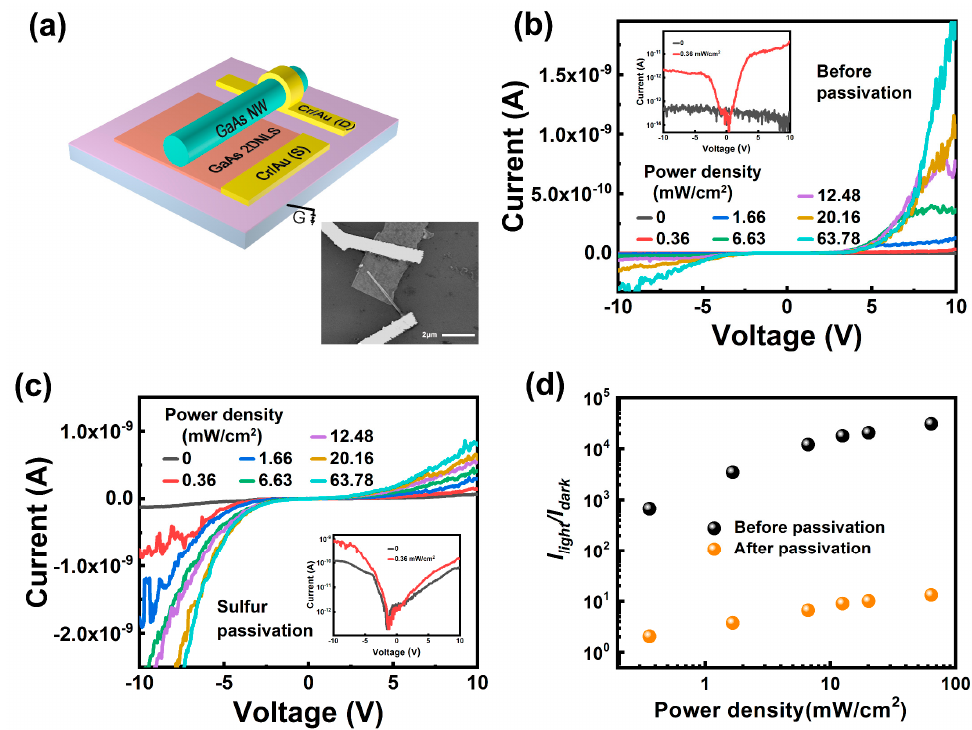
Figure 3. ( a ) Schematic illustration of mixed-dimensional GaAs photodetector; insert is the SEM image of the same. The I-V characteristics curves of the devices under different power densities ( b ) before and ( c ) after passivation. The inserts are dark currents and photocurrents at 0.36 mW/cm 2 on a logarithmic scale. ( d ) Ratios of photocurrent to dark current before and after passivation under different power densities at 8